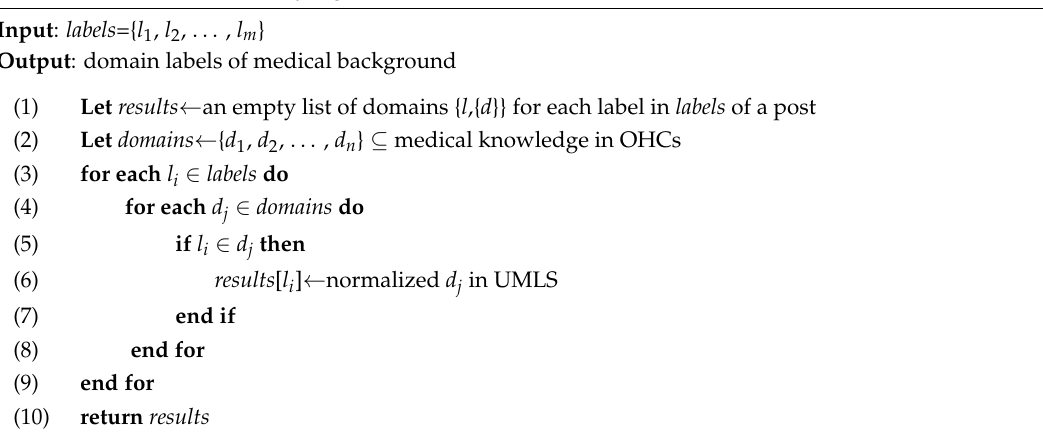
Algorithm 2 Domain discovery